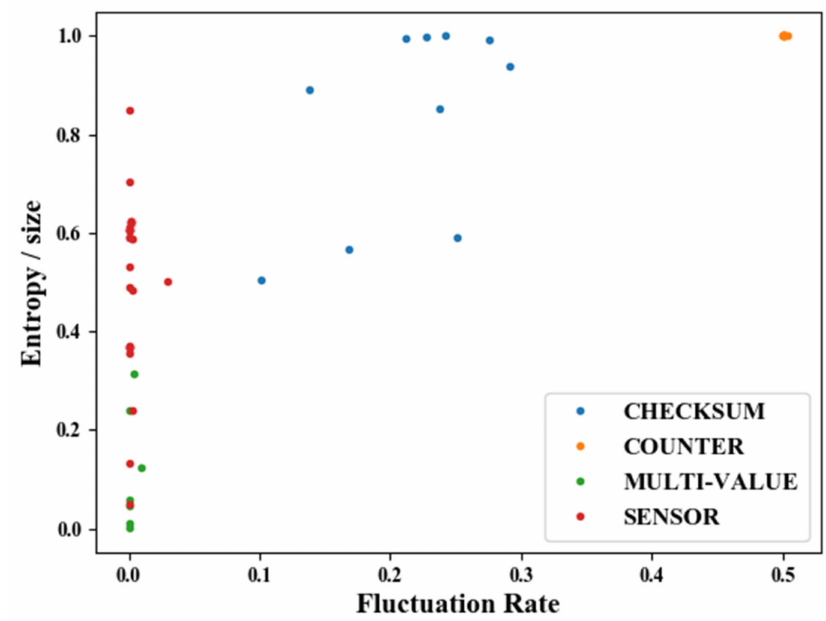
Figure 2. Distribution of FR and entropy/size values by signal